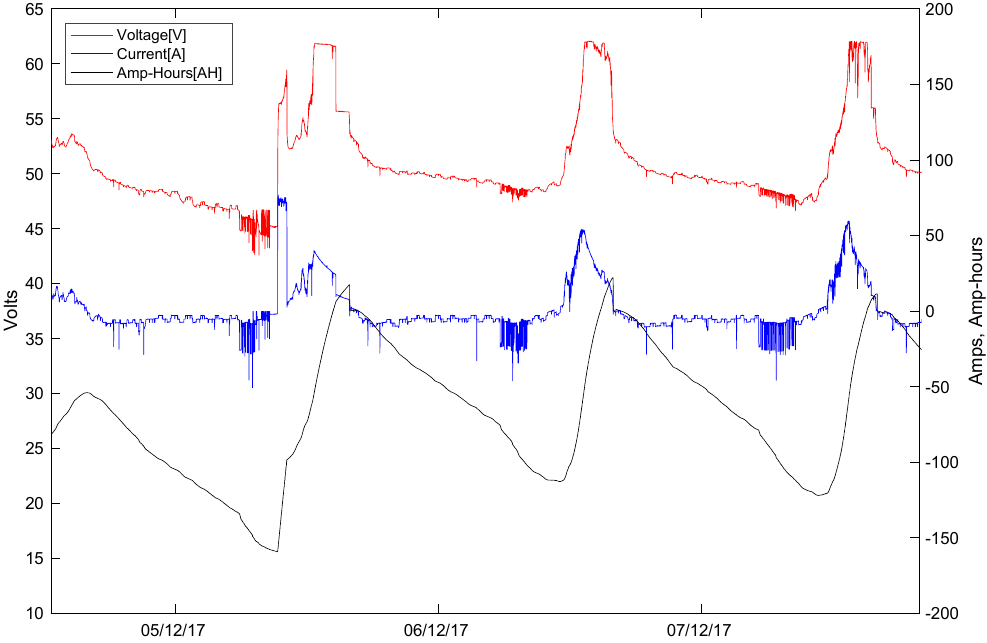
Figure 5. A detailed example of the reduced capacity battery bank with poor charge acceptance and inability to be effectively charged with genset or solar energy based on system controls as implemented.